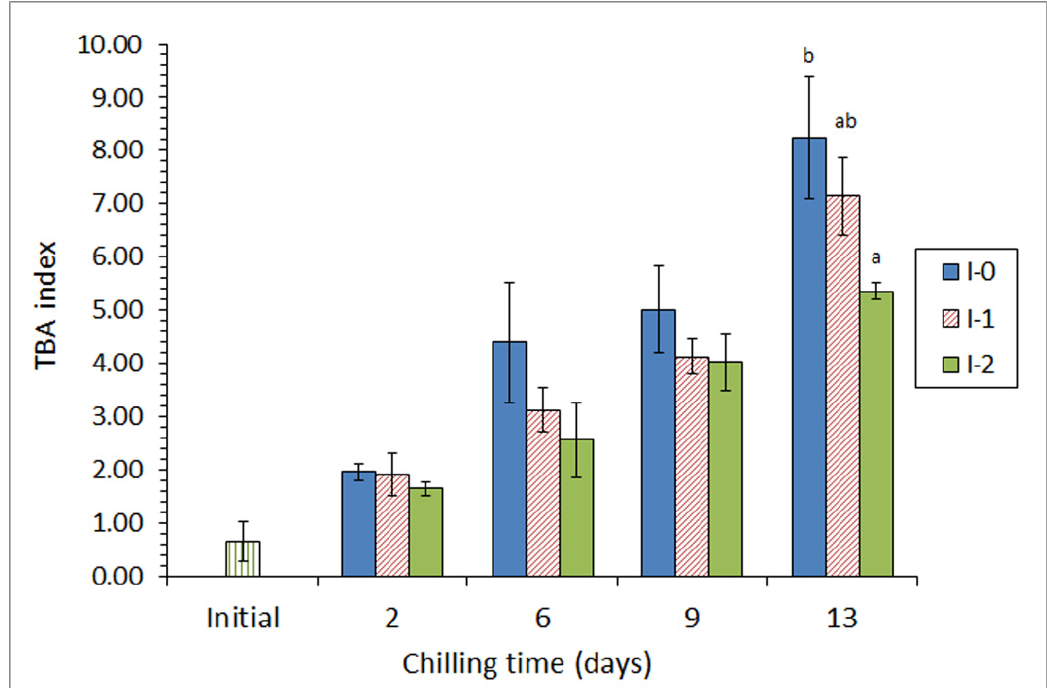
Figure 1. Evolution of thiobarbituric acid (TBA) index * in chilled chub mackerel subjected to different icing conditions **. * Average values of three independent determinations ( n = 3). Standard deviations are indicated by bars. Average values accompanied by different letters indicate significant differences ( p < 0.05). ** Icing conditions: I-0 (traditional ice; control), I-1 (ice including a low concentration of quinoa extract), and I-2 (ice including a high concentration of quinoa extract). Adapted from Miranda et al. [29] .